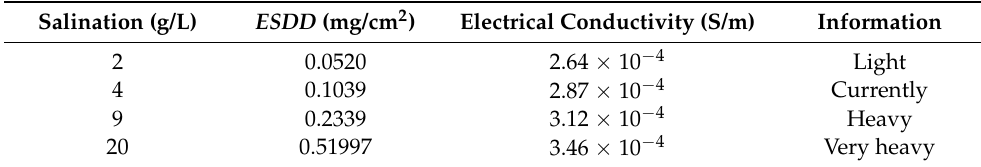
Table 3. Determination of salination, ESDD , and salt conductivity. Salination (g/L)